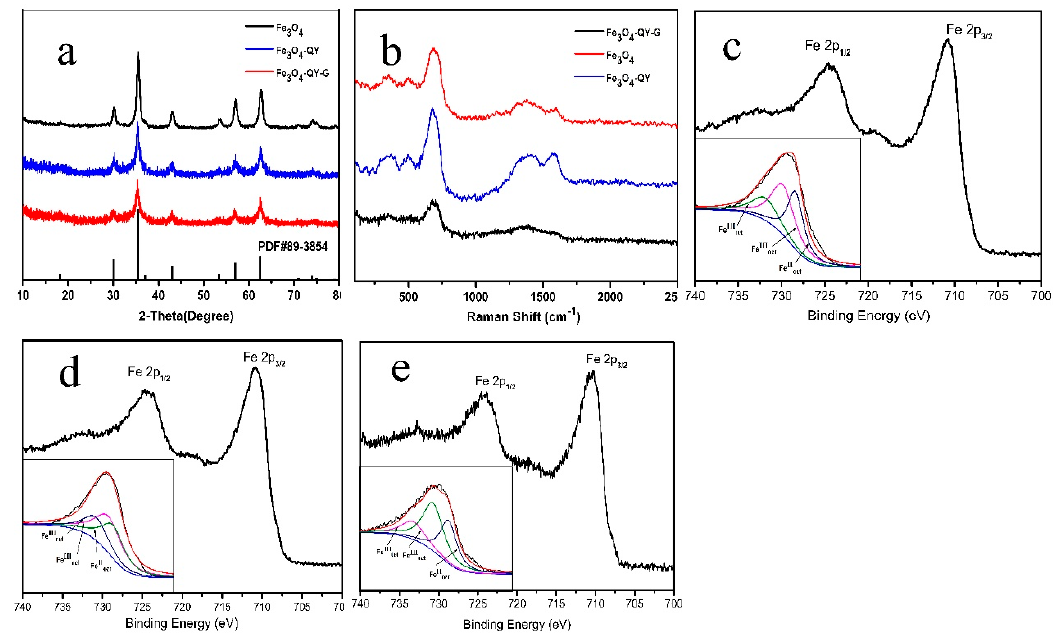
Figure 2. ( a ) XRD pattern of Fe 3 O 4 , Fe 3 O 4 -QY, Fe 3 O 4 -QY-G nanoparticles, ( b ) Raman spectrum of Fe 3 O 4 , Fe 3 O 4 -QY, Fe 3 O 4 -QY-G nanoparticles, XPS Fe 2p core-level spectra of ( c ) Fe 3 O 4 , ( d ) Fe 3 O 4 -QY, ( e ) Fe 3 O 4 ‐ QY ‐ G.